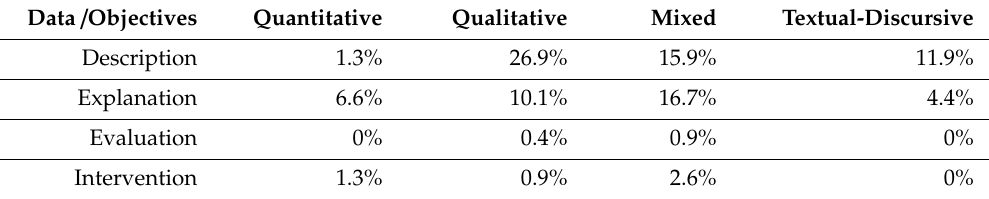
Table 2. Types of data vs. research